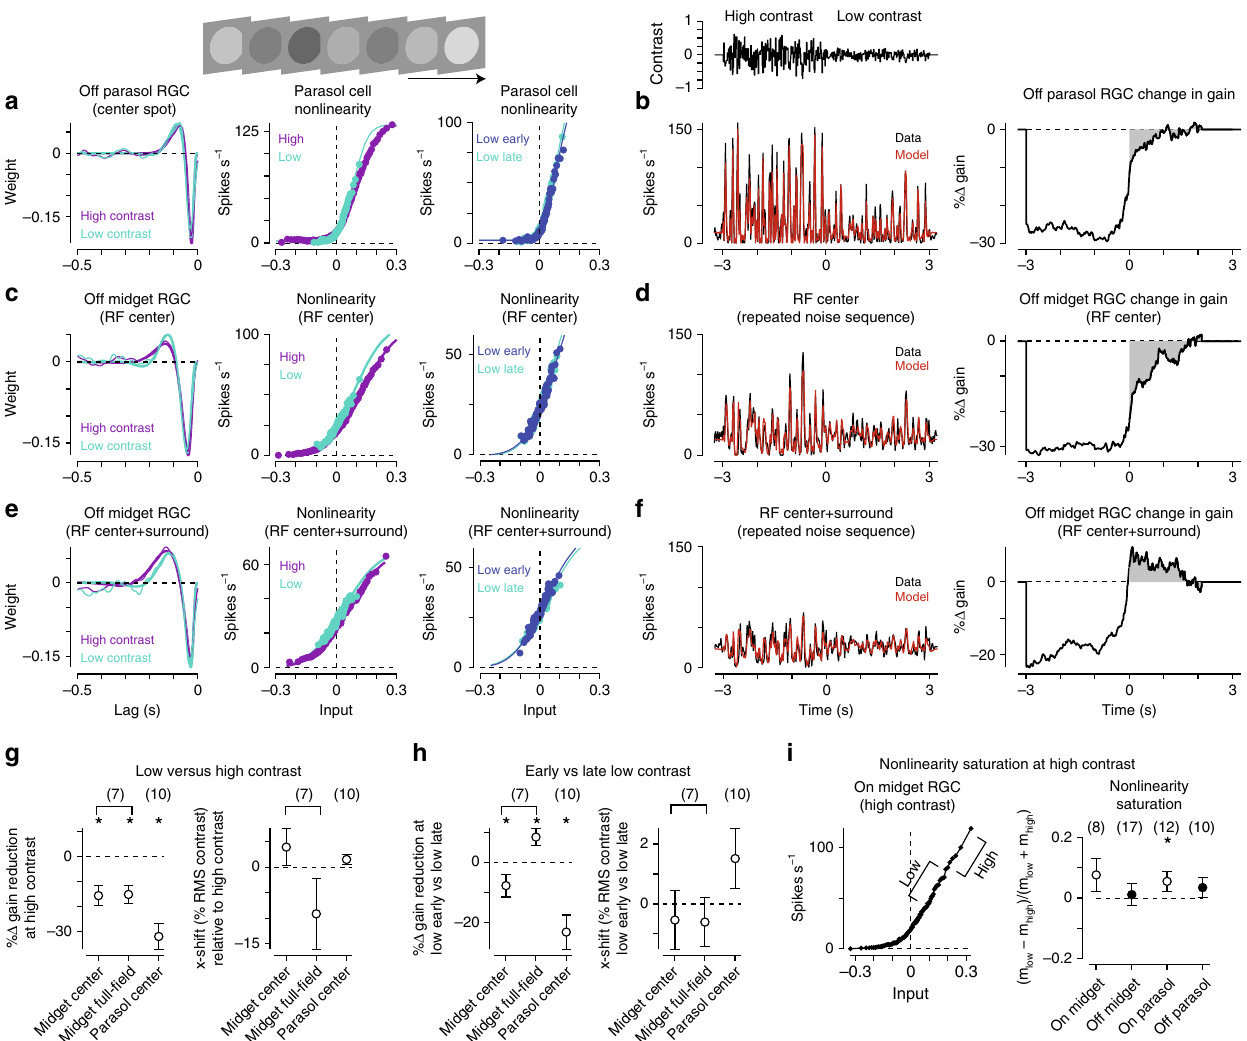
Fig. 5 Changes in stimulus variance evoke changes in the input – output properties of midget cells. a Temporal fi lters (left) and input – output nonlinearities (middle) in an Off parasol cell for the high and low-contrast periods. Separate nonlinearities were also calculated for the low-contrast region directly following the transition from high-to-low contrast (low early) and for the sustained low-contrast region (low late; right). b Average spike rate (black) and linear – nonlinear model prediction (red) for the repeated contrast trajectory (left). Data and model showed high correspondence (high contrast r 2 , 0.87 ± 0.02; low contrast r 2 , 0.73 ± 0.04; n = 10 cells). Right, average gain as a function of time. Values are shown relative to the sustained low-contrast period. Shaded regions indicate the period of low contrast. c Same as a for an Off midget ganglion cell to a small spot (diameter, 80 μ m) presented over the receptive- fi eld center. d Left: Spike rate (black) and model prediction (red) for repeated contrast trajectory (high contrast r 2 , 0.91 ± 0.02; low contrast r 2 , 0.71 ± 0.07; n = 7 cells). The cell ’ s gain was reduced following the shift to low contrast and recovered quickly to the level of sustained gain. e Linear – nonlinear model for the cell in ( c ) to a large spot (diameter, 730 μ m). f Responses of the cell in ( b ) for the large diameter spot (left). Following the transition to low contrast, gain quickly increased, exceeding the sustained level for ~2 s (right). g Left: Reduction in gain at high contrast relative to the low- contrast condition. Gain was signi fi cantly reduced at high contrast for both midget and parasol cells ( n = 7 midget cells; n = 10 parasol cells; p < 0.05). Right: Horizontal shift along the x -axis for the low contrast nonlinearity relative to high contrast. Wide- fi eld stimulation in midget cells evoked a shift of ~10% RMS contrast for the low-contrast condition indicating that lower contrasts were required to evoke the same spike rate as the high contrast condition. h Change in gain (left) and horizontal shift (right) for the early versus late low-contrast periods. i Nonlinearity saturation was measured for high contrast Gaussian noise (RMS contrast, 0.3) in midget and parasol ganglion cells. Saturation was quanti fi ed by comparing the slopes for the high and low- variance regions of the nonlinearity (left). The slope differences were near zero, indicating a lack of strong saturation in both midget and parasol ganglion cells (right); only On parasol cells showed saturation values that were signi fi cantly greater than zero ( p = 4.6 × 10 – 2 ; all other p > 0.1). Error bars indicate mean ± SEM. Statistical signi fi cance for paired values determined using Wilcoxon signed rank test and unpaired values with the Wilcoxon signed rank